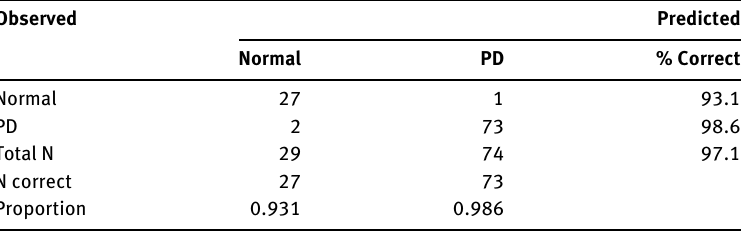
Table 5: Classification Using Test